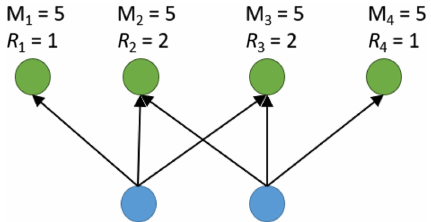
Figure 1. Example hub-and- spoke SCN with two transshipment hubs in blue and four demand nodes in green. The maximum number of demand nodes each transshipment node can supply is